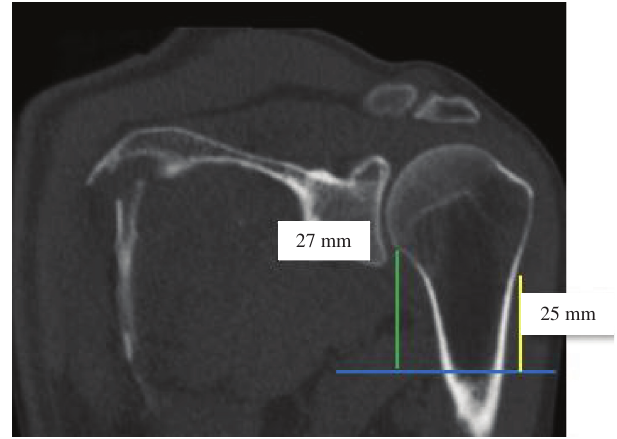
Figure 8. Mean values ± SDs for humeral height. Table 1. Humeral height ratios. Ratios Results PM-change of curvature with PM-anatomical